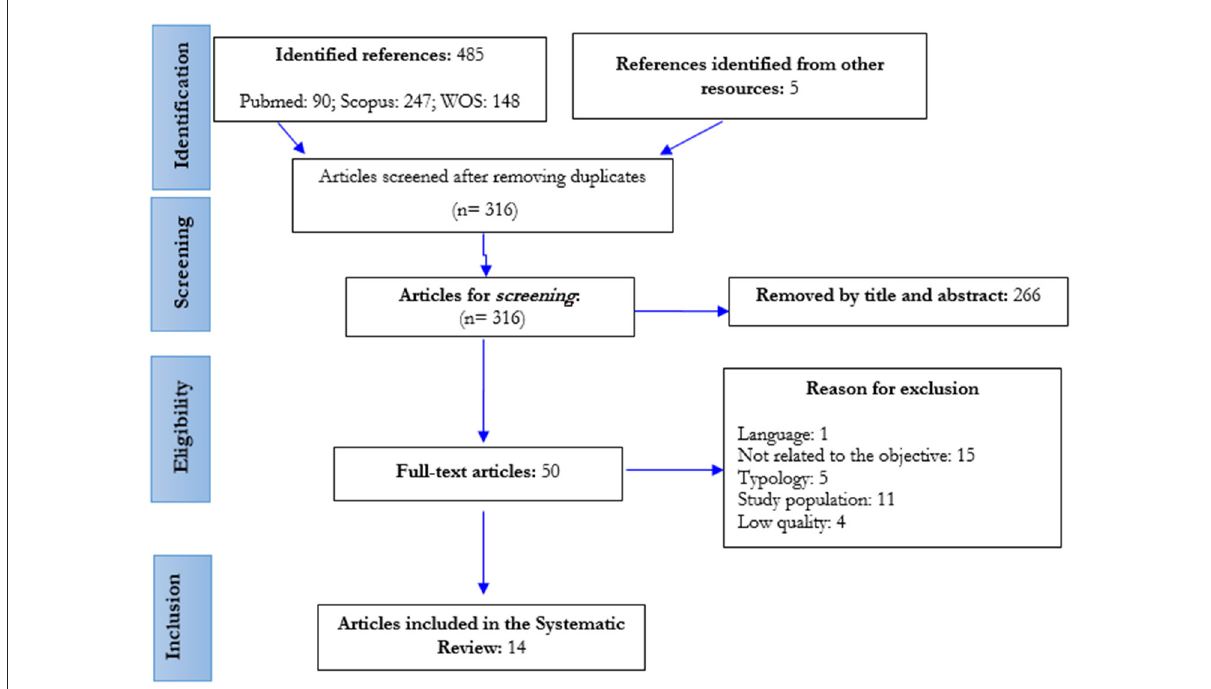
FIGURE1 Flowchart of the study selection process (PRISMA) (rehabilitation and COVID-19, Spain,